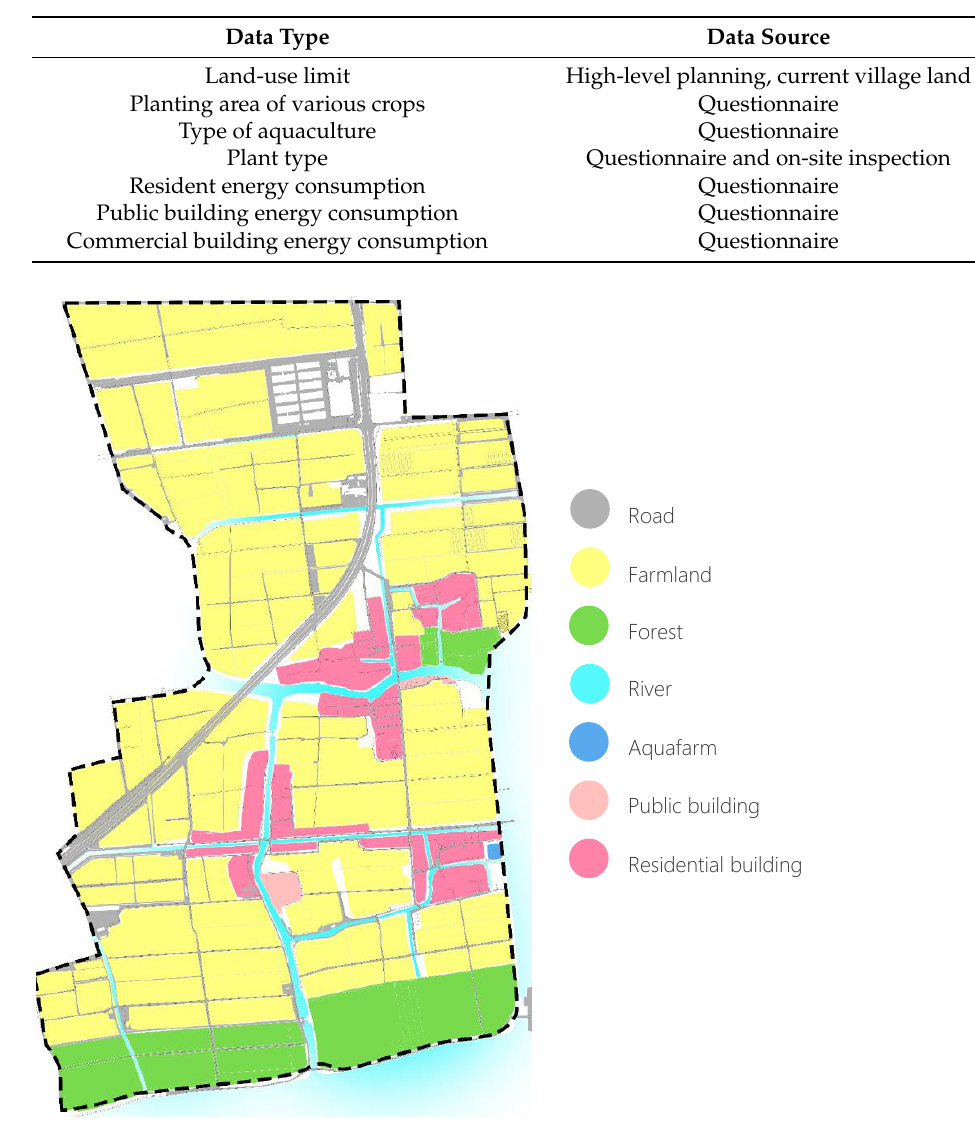
Table 4. Method used to acquire basic data.